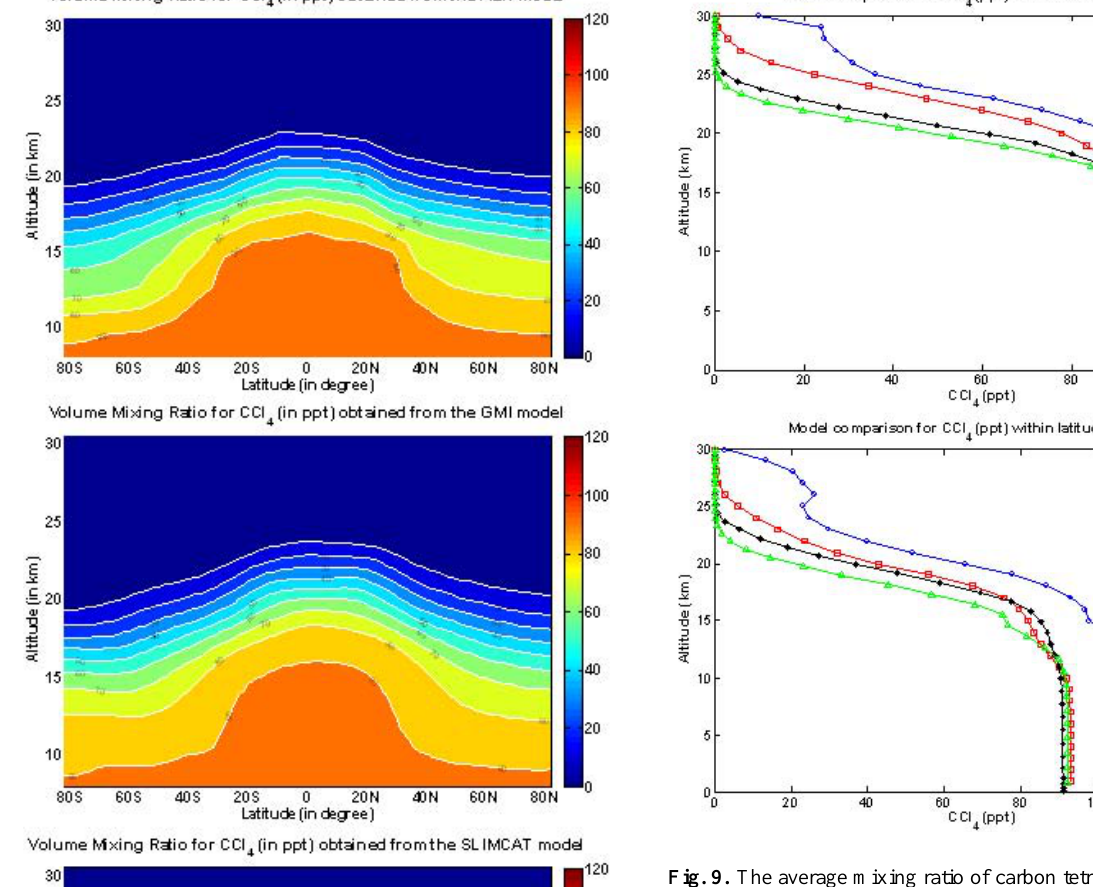
Fig. 9. The average mixing ratio of carbon tetrachloride as a func- tion of altitude for the AER (green line with triangles), GMI (black line with asterisks) and SLIMCAT (red line with squares) models compared with the average ACE profile (blue line with circles) be- tween the latitudes (a) 5 ◦ S–5 ◦ N and (b) 30–40 ◦